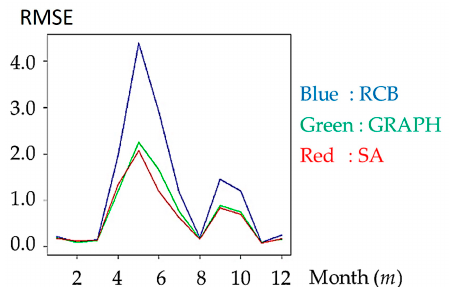
Figure 6. RMSEs (storage capacity vs. PV electricity) of the clusters optimized in each month.